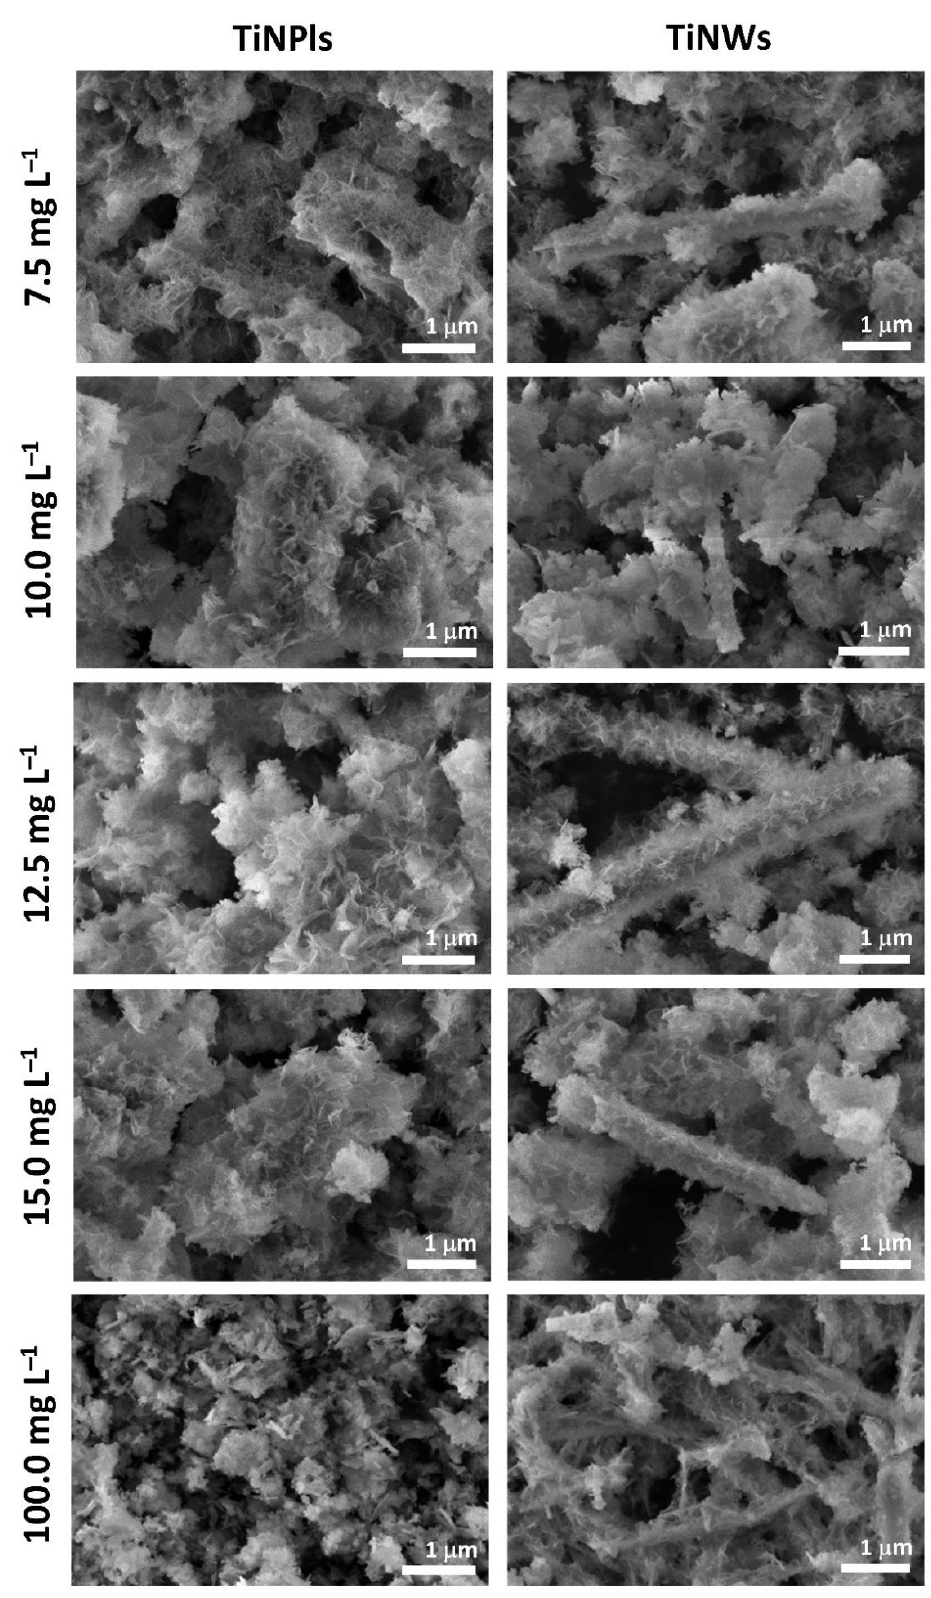
Figure 6. SEM micrographs of the precipitate formed in the presence of different concentration of Table 2. nanoplates (TiNPls) and nanowires (TiNWs) after 60 min reaction time. c (CaCl 2 ) = c (Na 2 HPO 4 ) = 4 · 10 −3 mol dm −3 , pH init = 7.4, ϑ = (25 ± 0.1) °C.